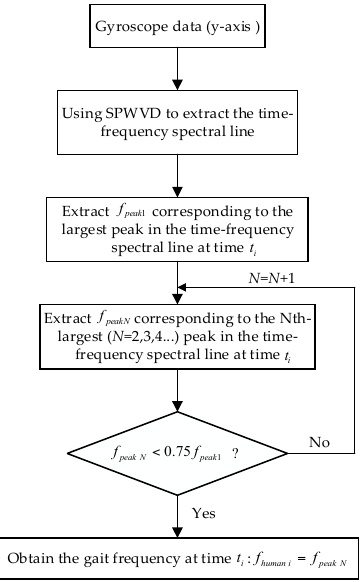
Figure 8. Flow chart of the time-frequency extraction method based on SPWVD-RMFI. During the walking process, the SPWVD-RMFI method proposed in this paper can extract the gait frequency correctly, which provides the foundation for the thresholds’ selection in the adaptive ZVI detection